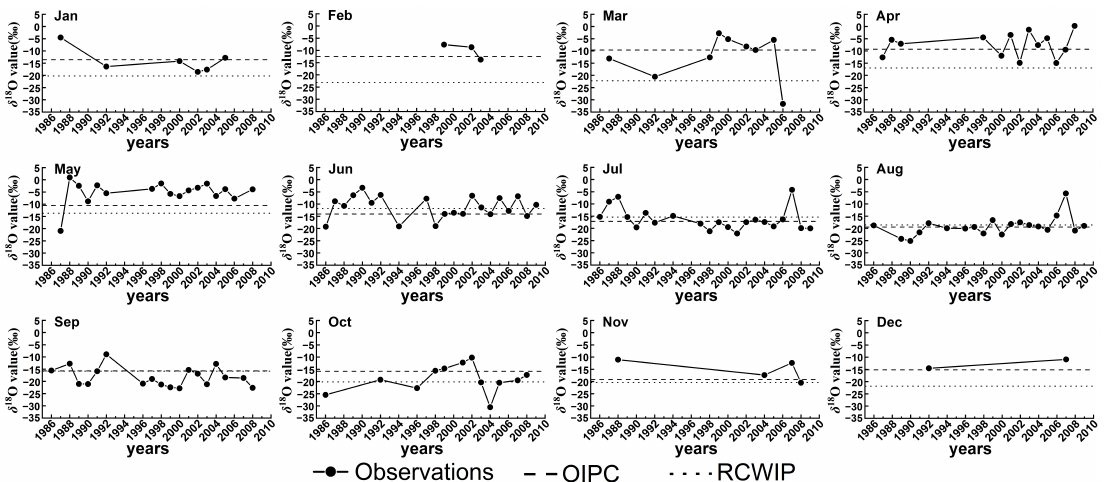
Figure 4. Comparison of monthly δ 18 O simulated by Online Isotopes in Precipitation Calculator (OIPC) and Regionalized Cluster-based Water Isotope Prediction (RCWIP) and observed in Lhasa from 1986 to 2009.